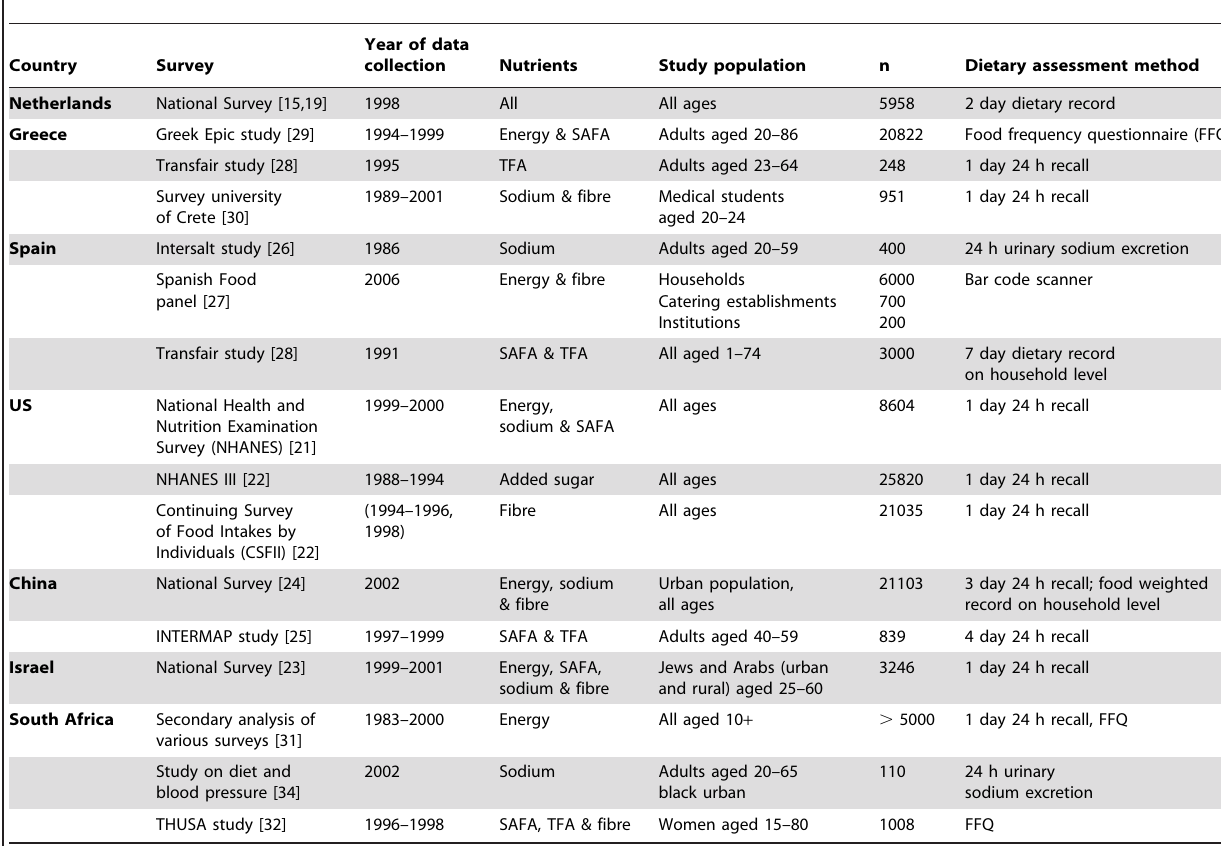
Table 2. Overview of nutrient intake data sources for the various countries.